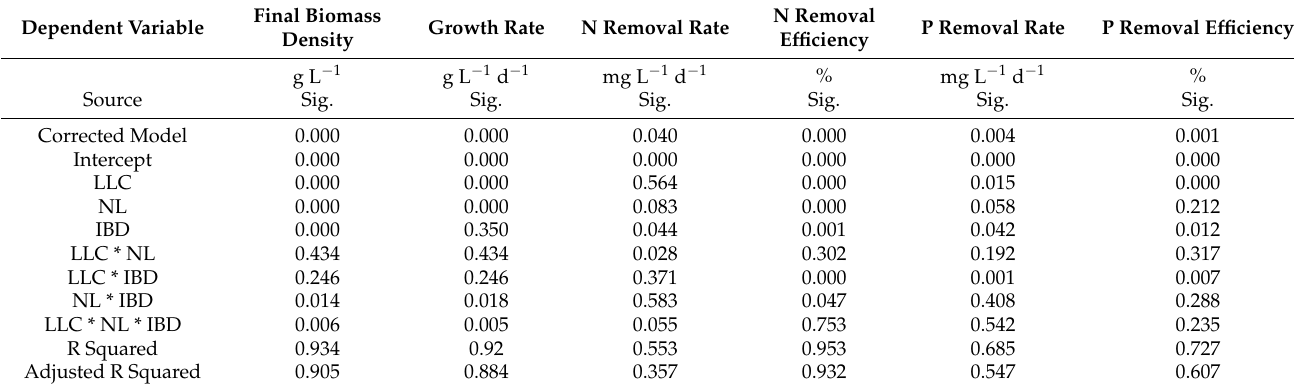
Table 3. Statistically significant regression